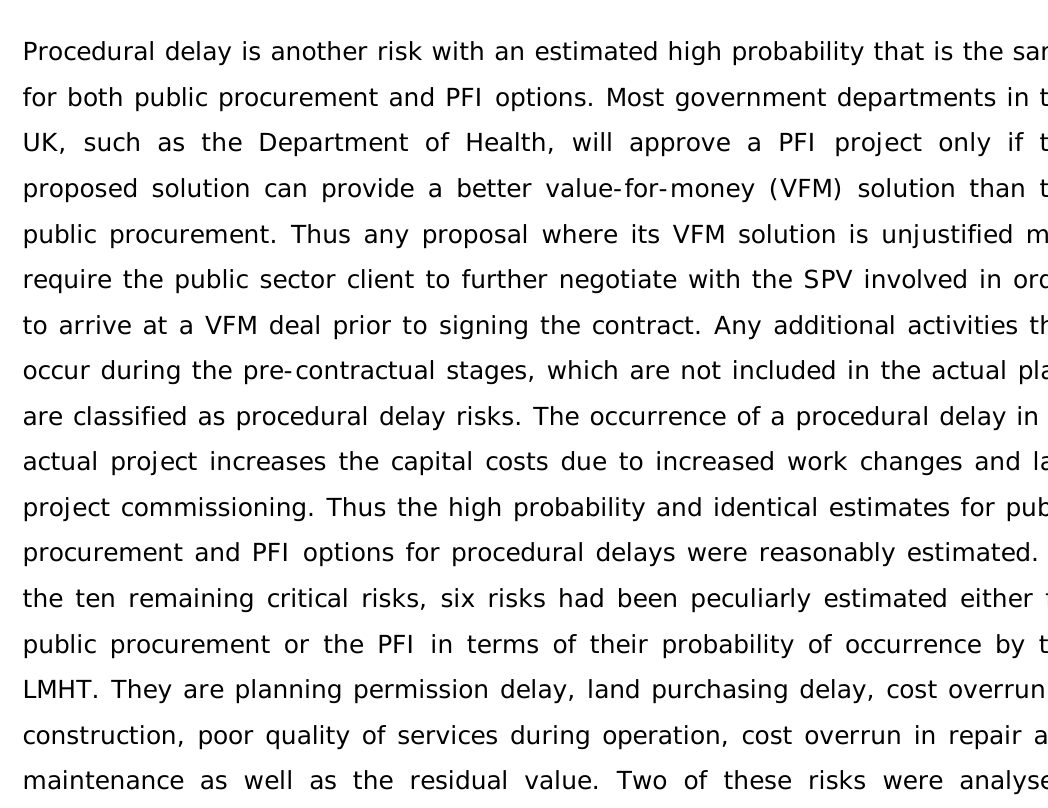
Figure 3. "Thirteen High Probability Risks for Public